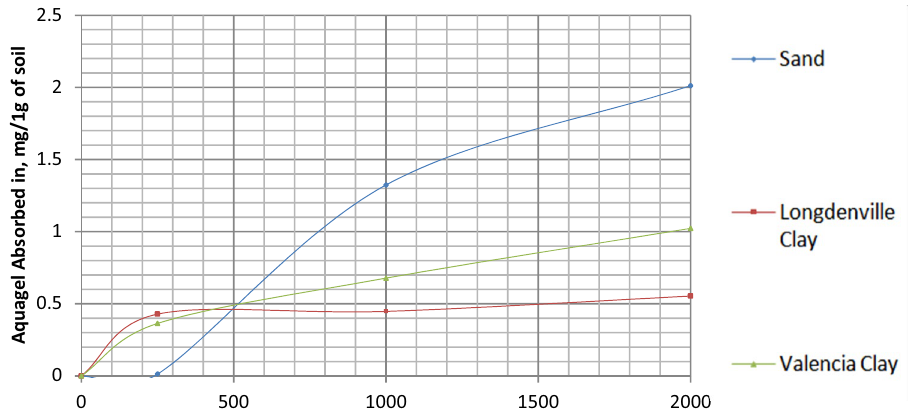
Fig. 8 Aquagel polymer adsorp- tion on sand, Valencia clay and Longdenville